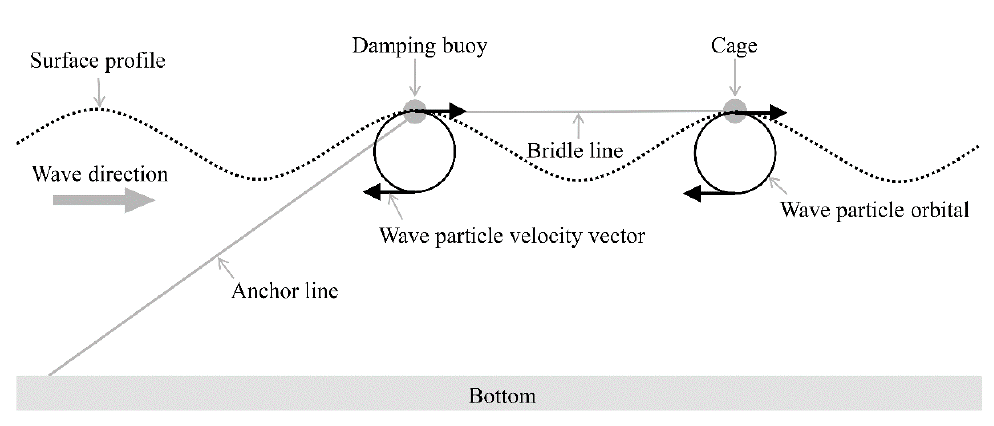
Figure 9. An illustration of a situation in which the mooring tension is maximized when the wavelength is the same as the bridle-line length.